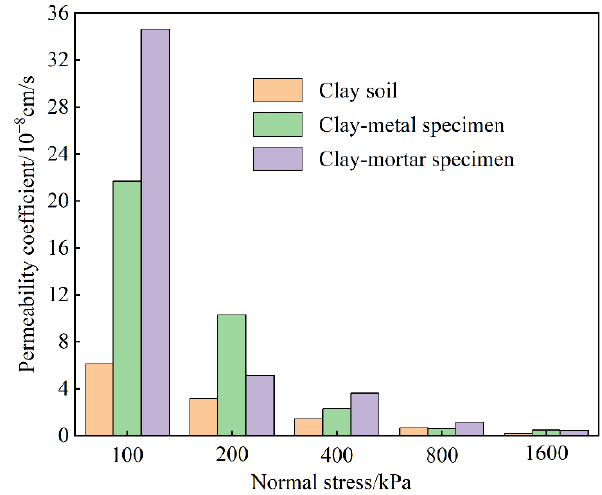
Figure 9. Contact seepage results of initial interface.